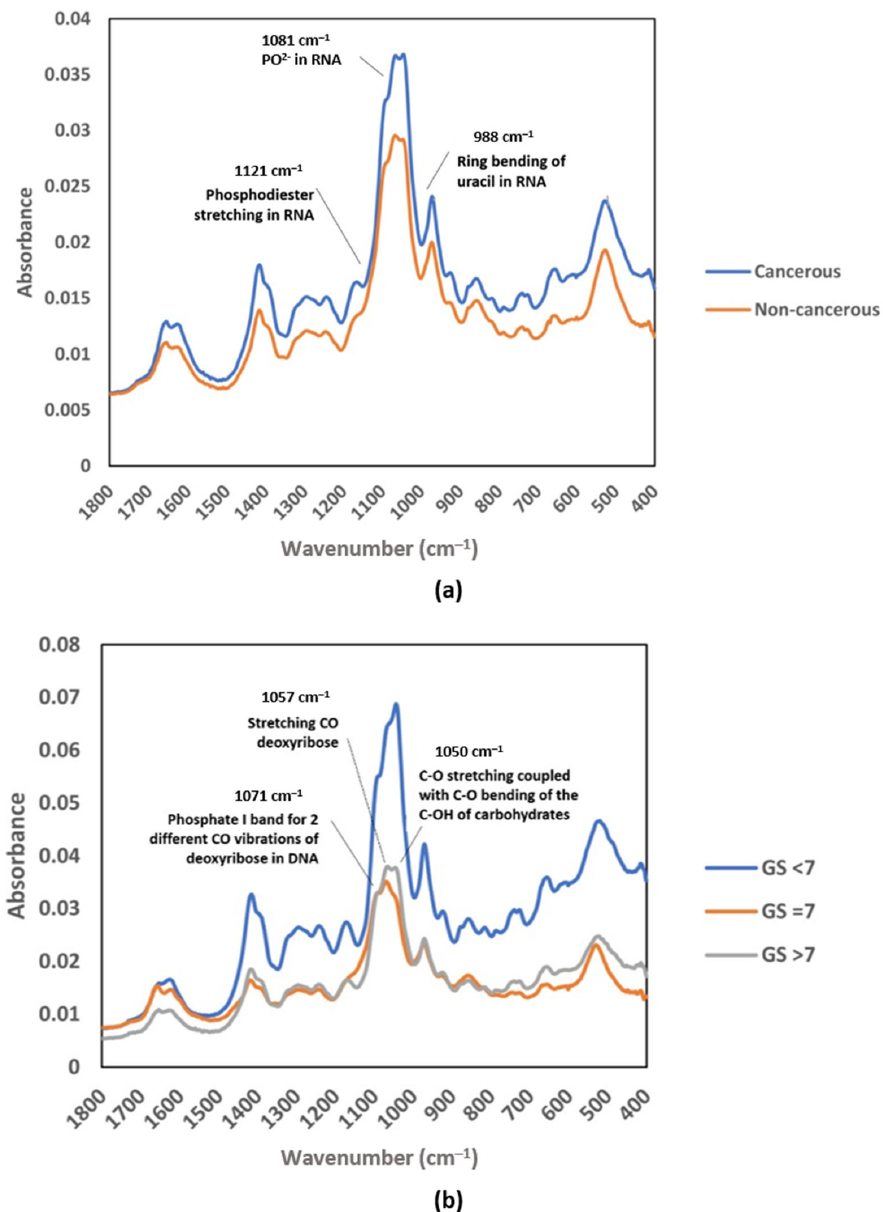
Figure 3. Average raw FTIR spectra of urinary EVs in the MIR fingerprint region: ( a ) cancerous patients and non-cancerous individuals; ( b ) Gleason score groups (GS < 7, GS = 7, and GS > 7). Reproduced with permission from ref. [34], Membranes ; published by MDPI, 2021.